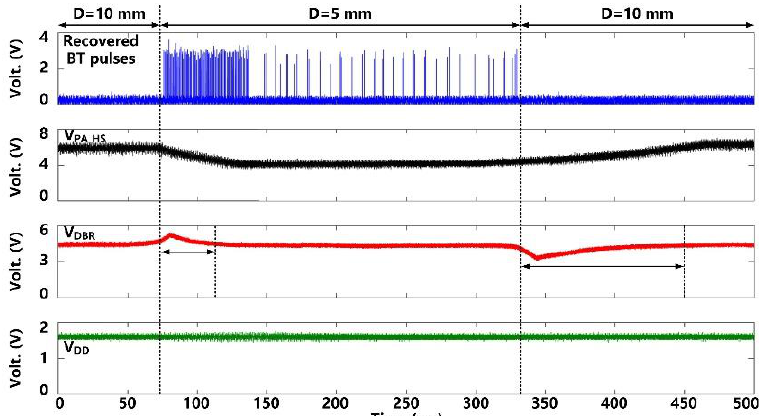
Figure 10. Measured electrical stimulation waveforms with active charge balancing.